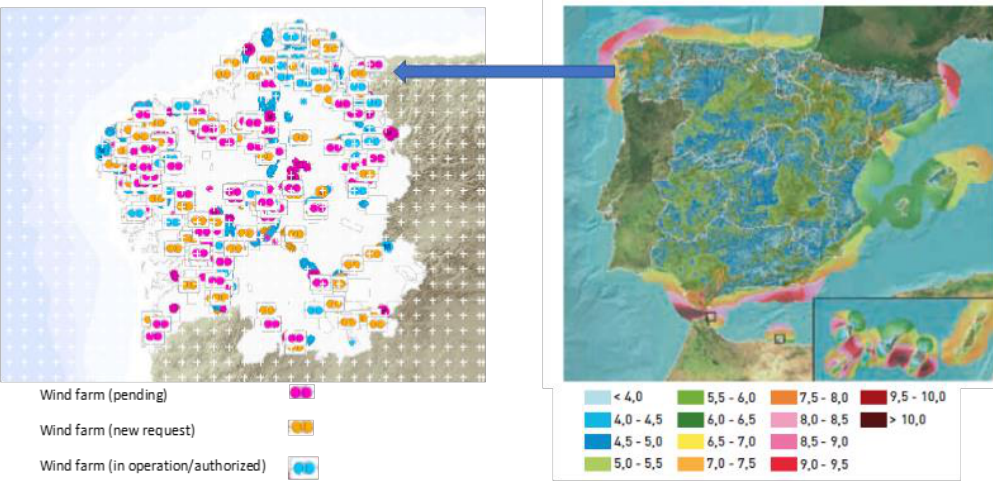
Figure 3. Wind energy capacity by regions in Spain (MW) (1998 – 2017) elaborated from [70 – 72].